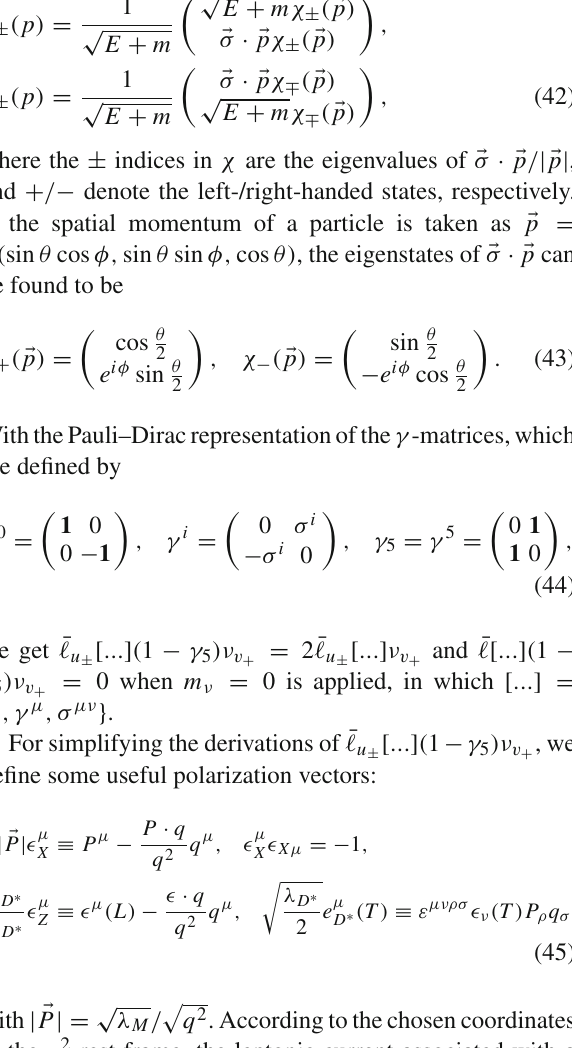
Table 1 Values of integrated FBA, R D ( D ∗ ) , and P τ out charged-Higgs effects in some chosen benchmarks of (χ u ct ,χ (cid:4) (cid:4)(cid:4) ) , where we have fixed m H ± = 400 GeV and tan β =